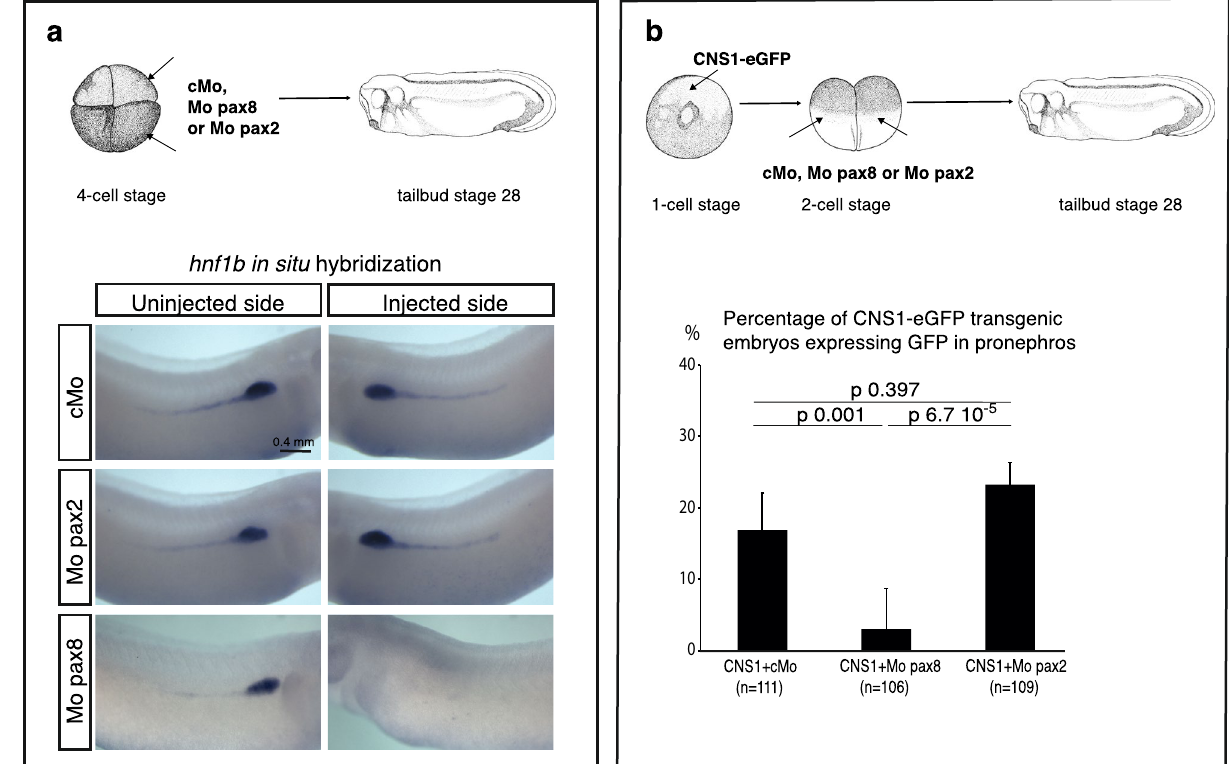
Figure 5. Endogenous pax8, but not pax2 , is required for hnf1b expression and CNS1 activity in the pronephros at tailbud stage. (a) Pax2 depletion does not affect hnf1b expression at stage 28 . 4-cell stage embryos were injected into the two left blastomeres with either a control Mo (cMo), a mix of two morpholinos, Mo Pax8 and Mo Pax8.B, (named Mo pax8 for simplicity) or Mo Pax2.2 (named Mo pax2). They were further cultured until tailbud stage 28 and processed for hnf1b whole-mount in situ hybridization. Hnf1b pronephric expression is strongly inhibited in 80% (n = 24) of pax8 depletion. In contrast, pax2 depletion has no significant effect on hnf1b pronephric expression (n = 60), as embryos injected with cMo (n = 71) (three independent experiments). (b) Pax2 depletion does not affect CNS1-driven GFP expression in the pronephros . F0 CNS1-eGFP transgenic embryos were generated by the I-Sce I meganuclease method at the 1-cell stage. At the 2-cell stage, same mixes of Mo as in ( a ) were injected into every blastomeres. GFP expression was monitored by whole-mount in situ hybridization in embryos cultured until the tailbud stage 28. The histogram indicates the percentage of CNS1- eGFP transgenic embryos showing GFP expression in controls, or upon depletion of pax2 or pax8. In contrast to pax8 depletion, pax2 depletion has no significant effect on CNS1 activity. Statistical significance was determined using Fisher’s exact test. P-values are annotated on the figure. Combined results from three independent experiments. n indicates the total number of analysed